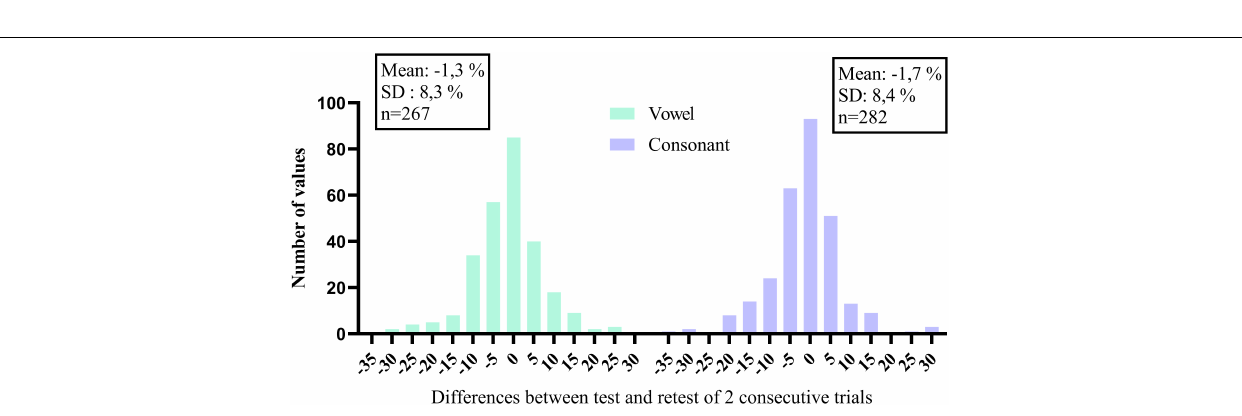
Frontiers in Neuroscience |